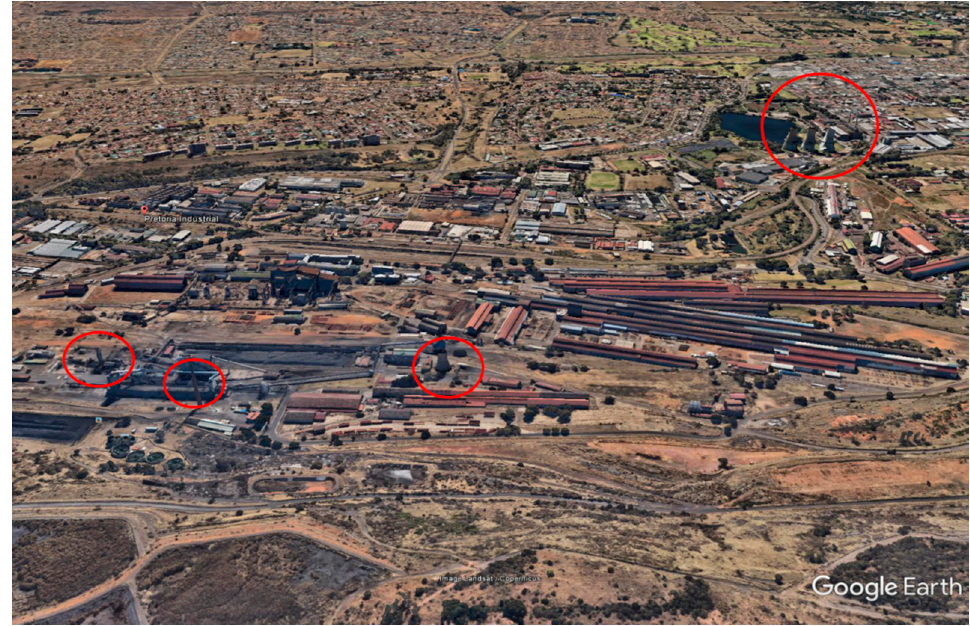
Figure 1. Google Earth image depicting Pretoria West industrial area. Source: Morakinyo et al. [20–22]. Red rings indicate some of the emission stacks in the study area.